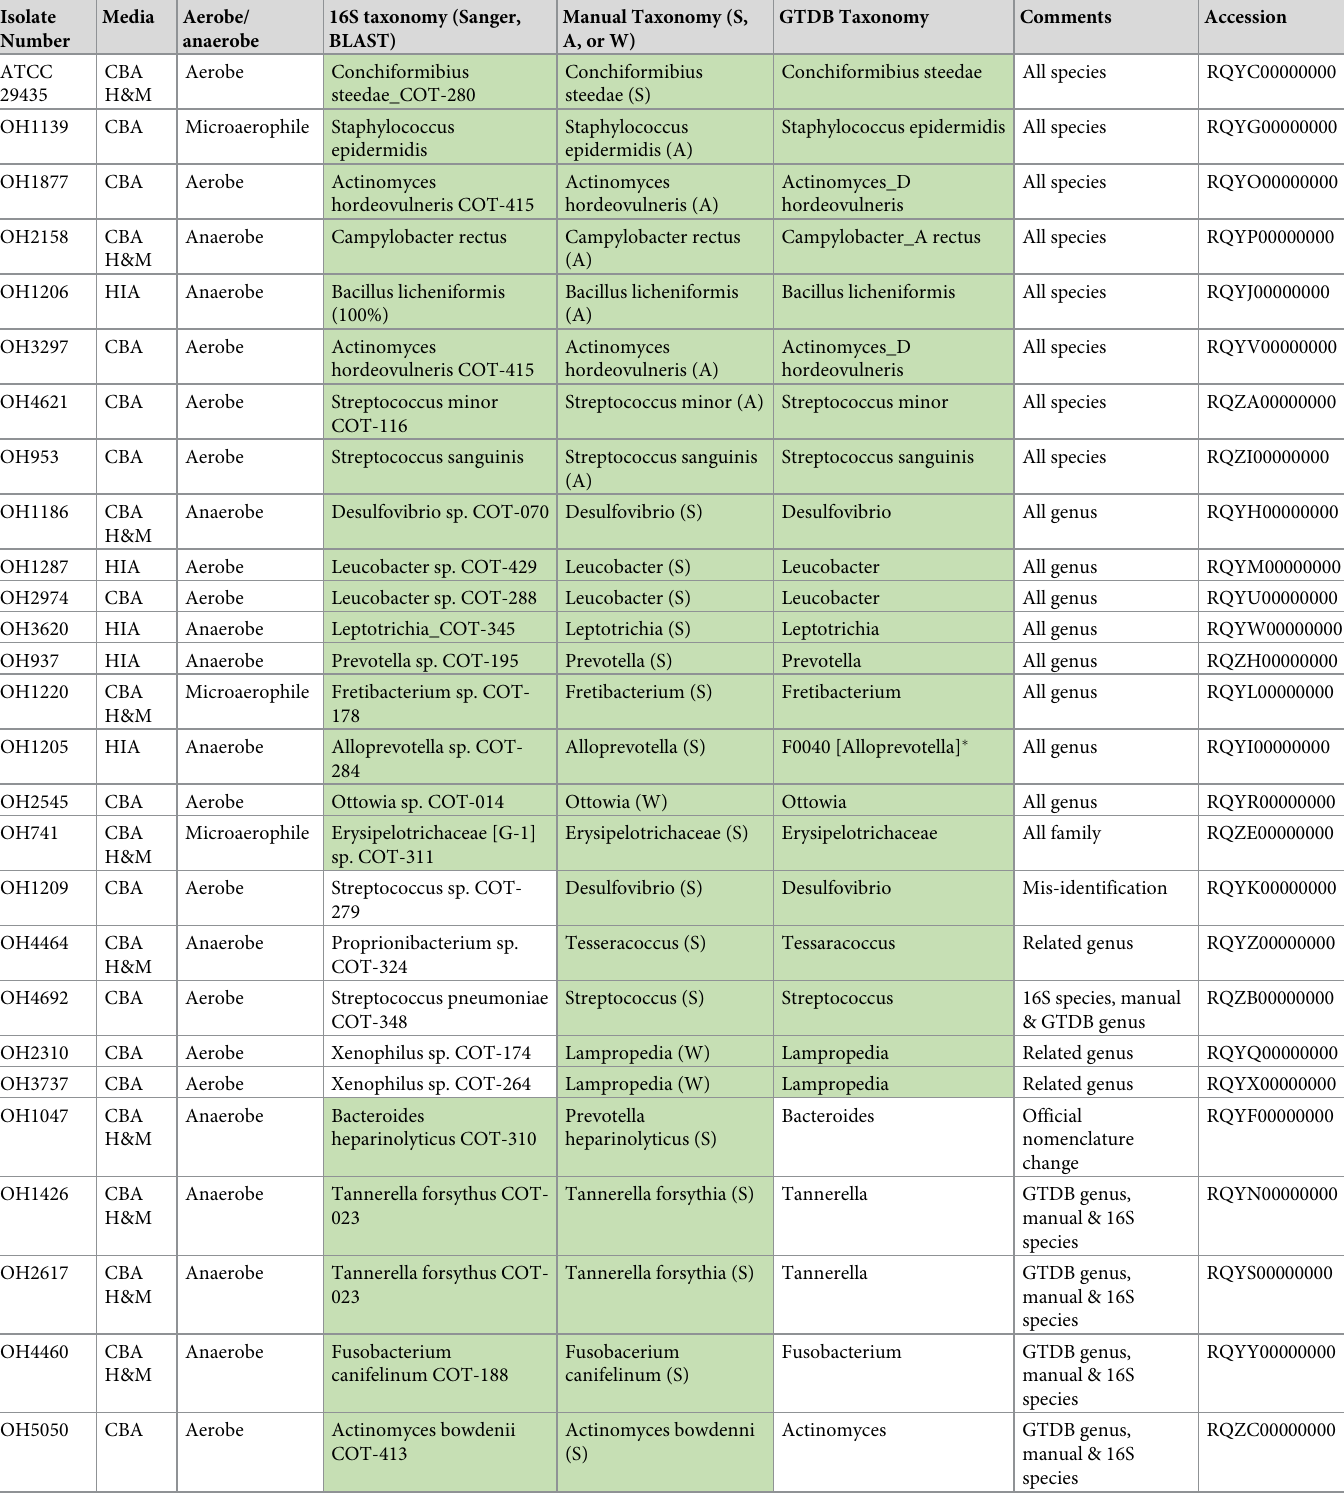
Table 1. Comparative taxonomy of 33 bacterial strains by three different methods. Isolate